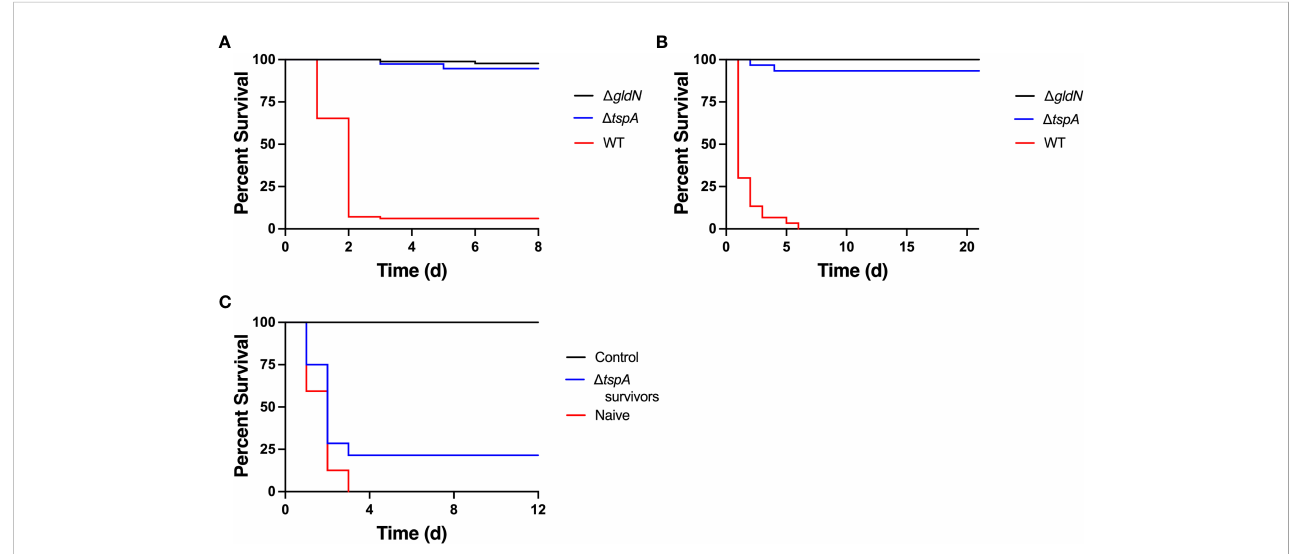
FIGURE 7 Effect of deletion of tspA , which encodes a tail-speci fi c protease, on virulence. Strains examined were wild-type F. columnare (WT), D tspA , and D gldN. ( A ) Rainbow trout alevin were exposed by immersion to F. columnare and survival was monitored for 8 d. The fi nal challenge concentrations were 6.9 × 10 6 CFU/mL (WT), 1.1 × 10 7 CFU/mL ( D gldN ), and 9.0× 10 5 CFU/mL ( D tspA ). Signi fi cant differences in percent survival for fi sh challenged were observed between the WT and D tspA ( P <0.0001). (B) Rainbow trout juveniles were exposed by immersion to F. columnare strains and survival was monitored for 21 d. The fi nal challenge concentrations were 3.4 × 10 7 CFU/mL (WT), 6.6 × 10 5 CFU/mL ( D gldN ), and 9.6 × 10 6 CFU/mL ( D tspA ). Signi fi cant differences in percent survival for fi sh challenged were observed between the WT and D tspA ( P <0.0001). (C) Juvenile rainbow trout that survived exposure to D tspA ( D tspA survivors) were examined for resistance to wild-type cells. Naïve fi sh and D tspA survivors were maintained for 28 d and then exposed to wild-type cells at 3.8 × 10 7 CFU/mL. Survival was monitored for 12 d. Fish were exposed to TYES without bacteria as a control. Signi fi cant differences in percent survival for fi sh challenged were observed between naïve fi sh and D tspA survivors ( P